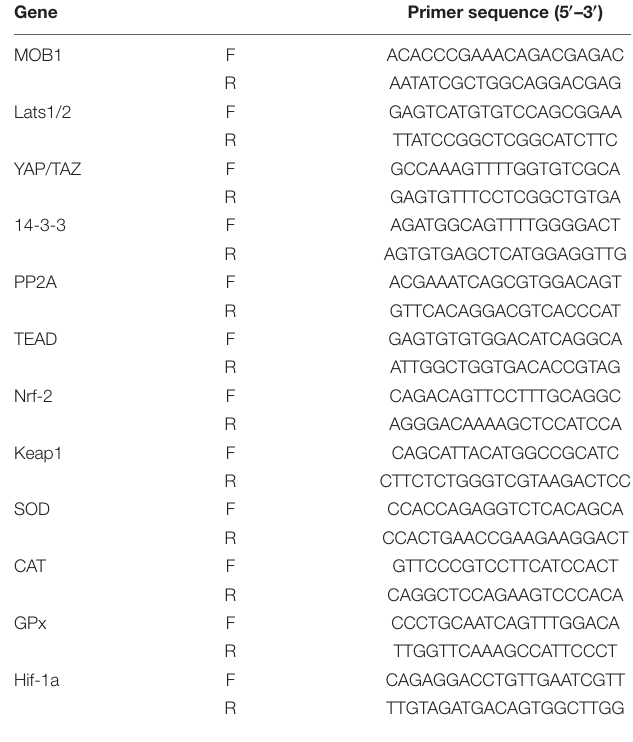
TABLE 1 | Sequences of primers used in